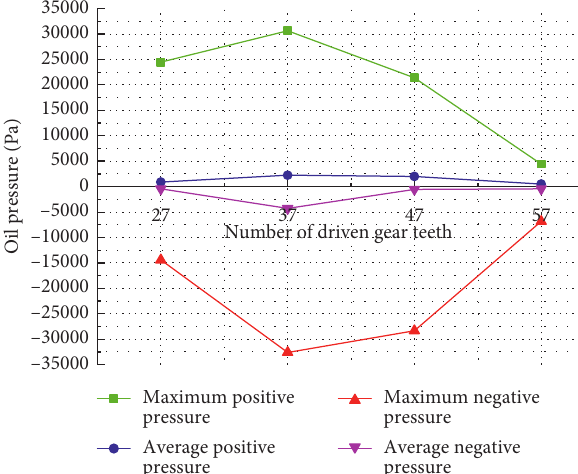
Figure 13: Oil pressure distribution along the tooth width direction. Figure 14: Oil pressure against different injection